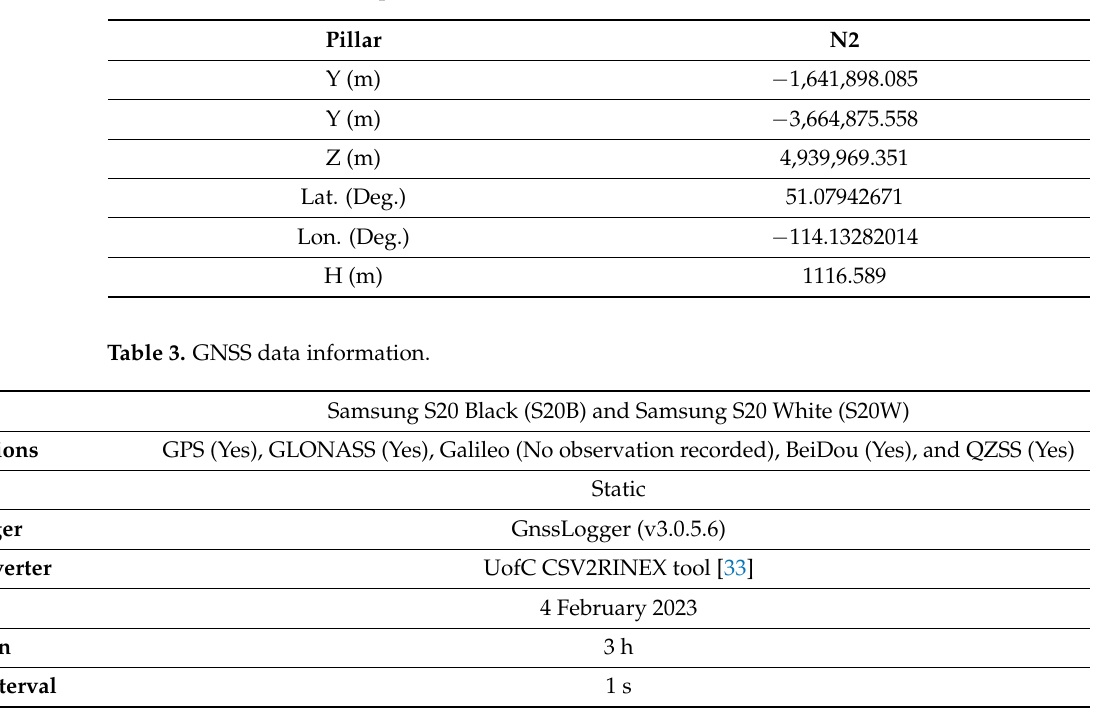
Figure 1. Two Samsung S20 smartphones generate a very short baseline. Table 2. True coordinate of pillar N2.